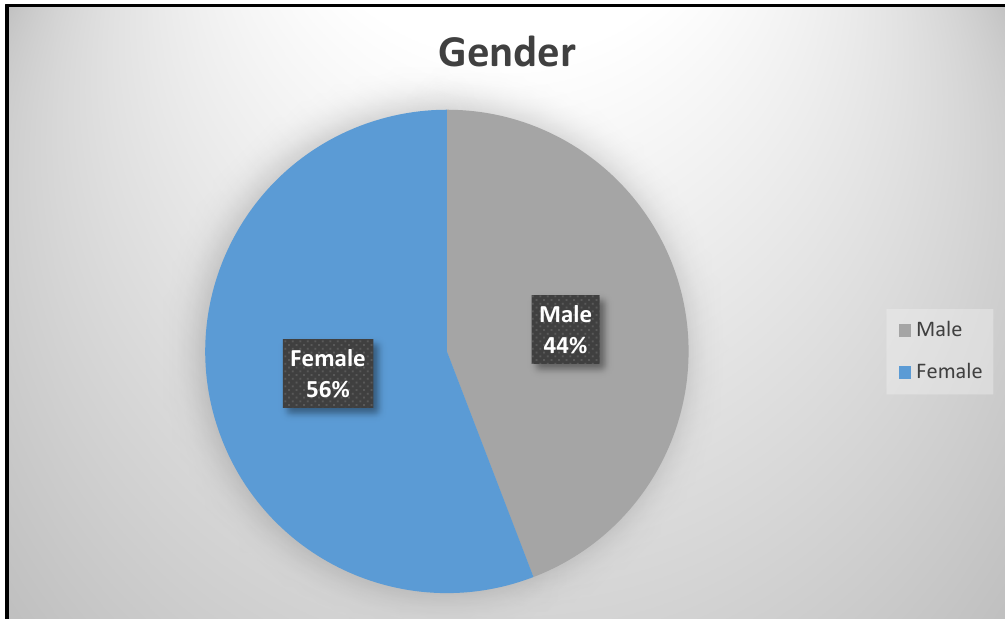
Figure 1. Gender distribution.